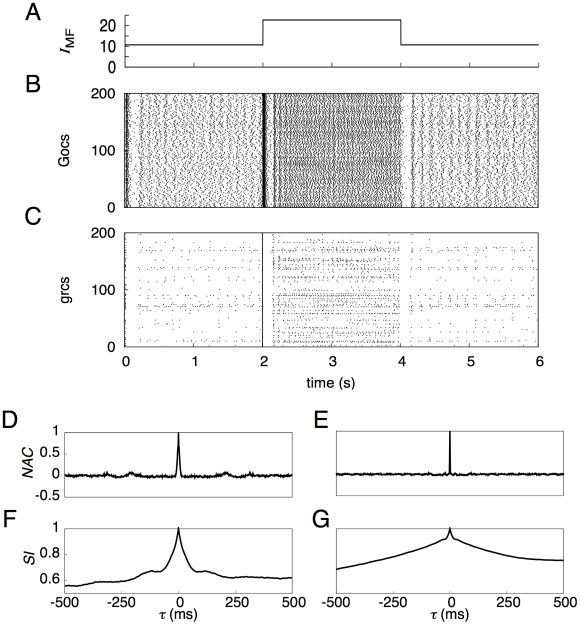
Activities of grcs and Gocs when NMDA channels of Gocs were continually open.Conventions are as in Fig. 2. When a small current was injected, the Gocs elicited spikes at high frequencies (B), which in turn strongly inhibited the grcs. Consequently, the generation of oscillatory spikes at grcs disappeared (C). The absence of the oscillation was demonstrated by the sharp peak of NAC(τ) at τ = 0 (D). The overlap of active grc populations decreased rapidly with the separation of time (F). When a large current was injected, the Gocs also fired at high frequencies, too (B). In this case, however, the populations of active grcs exhibited random alternation between the burst and silent modes although the grcs elicited spikes sparsely (C, compared with Fig. 2C
). This random spike pattern was demonstrated by the sharply localized peak of NAC(τ) at τ = 0 and otherwise, NAC(τ) ≈0, as shown in E.  monotonically decreased as |τ| increased (G), indicating that the population of active grcs changed gradually to different populations with time without recurrence.